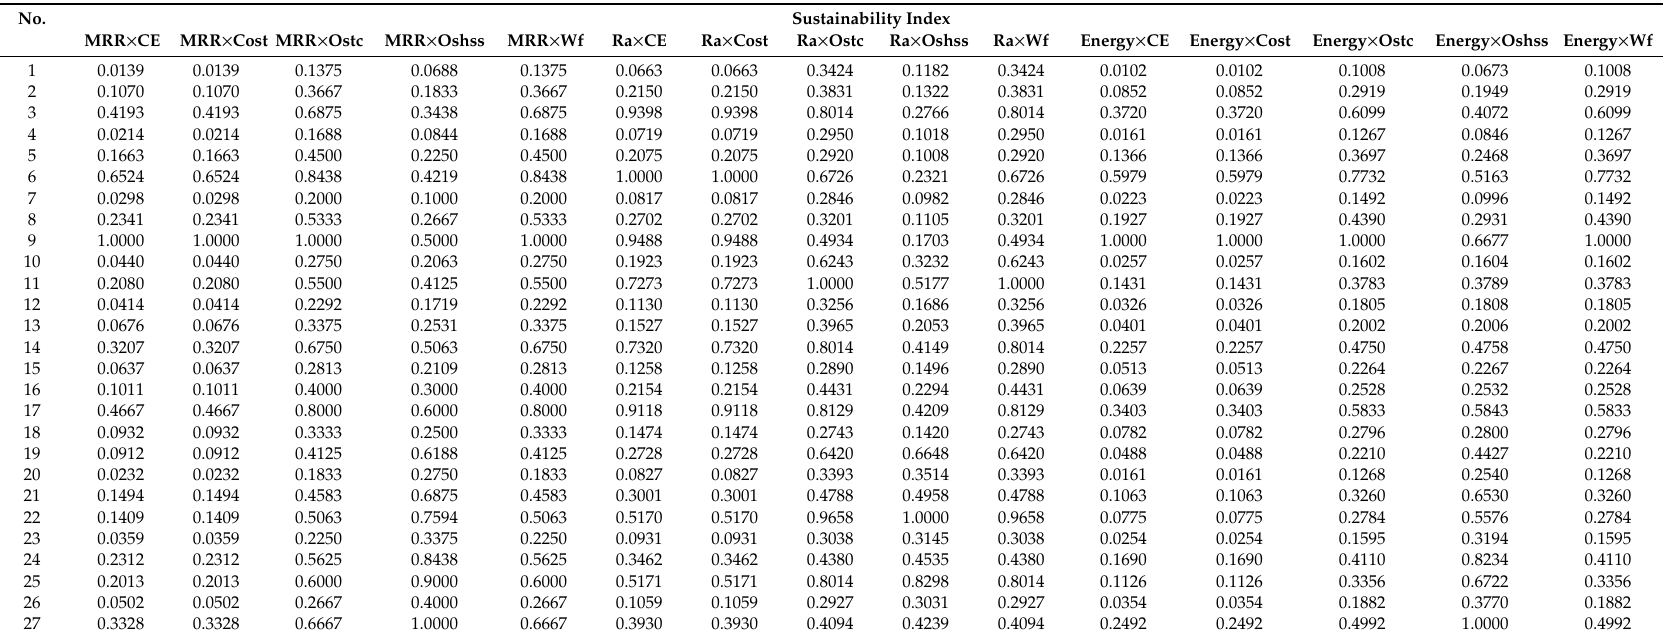
Table A2. OPAI Step 2: Calculation of the sustainability